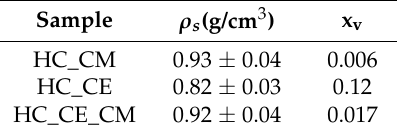
Table 3. Density of polyethylene homo-composites after different